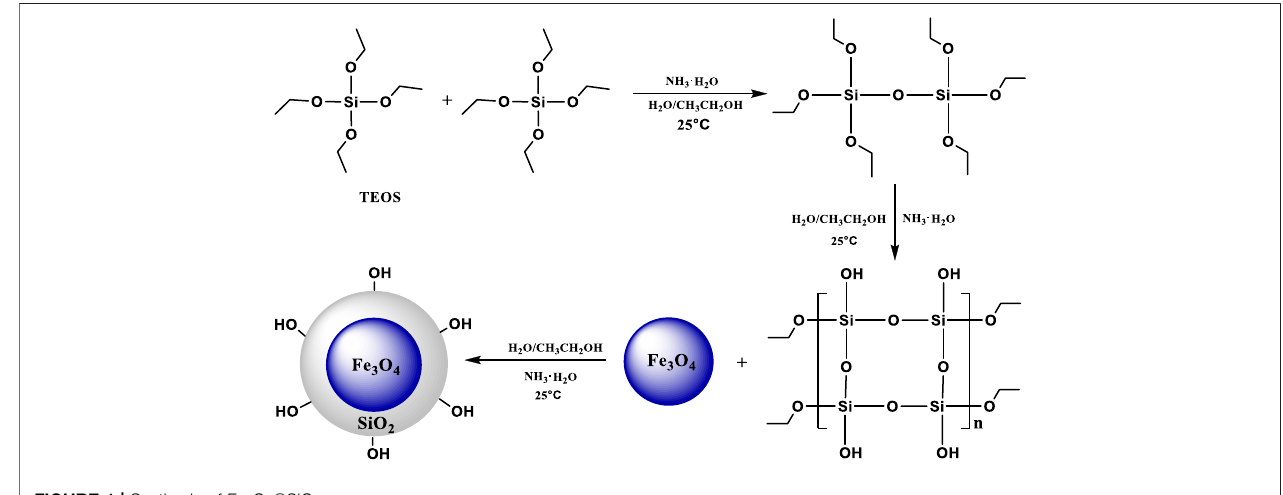
FIGURE 1 | Synthesis of Fe 3 O 4 @SiO 2